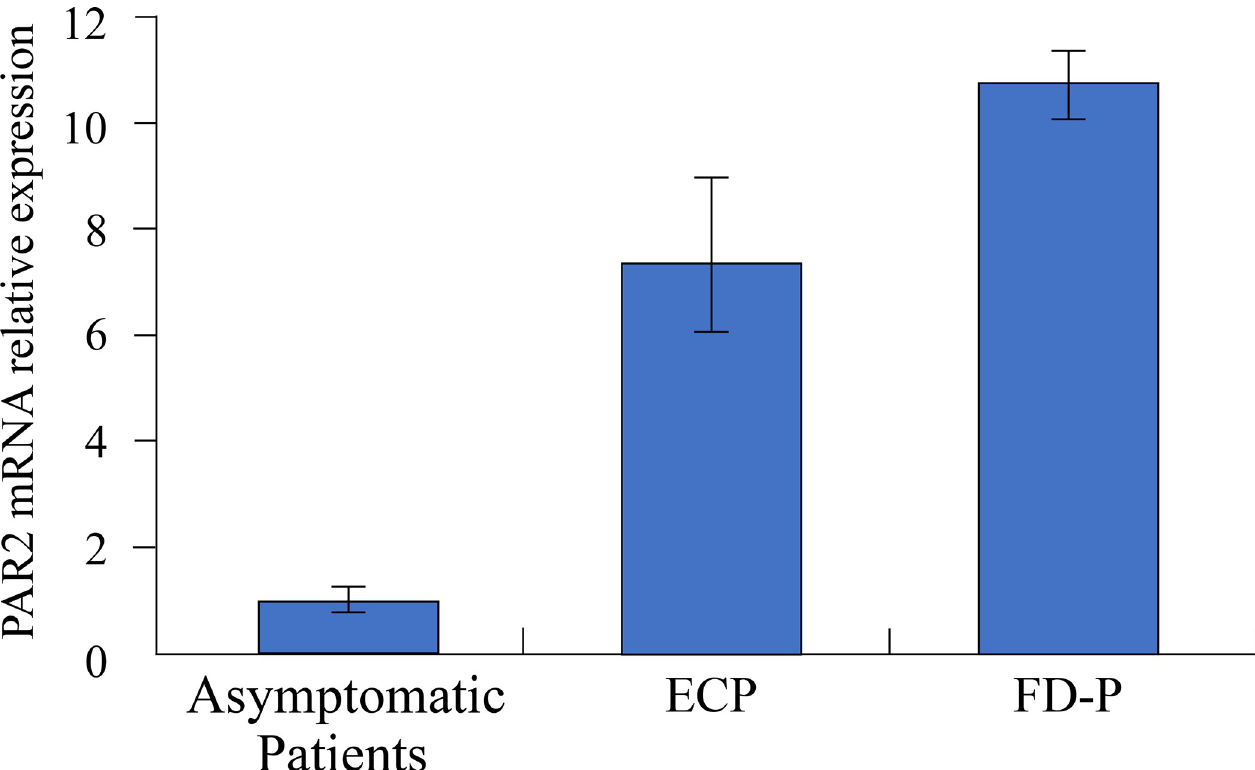
Fig 7. Comparison of PAR2 mRNA levels in duodenal mucosa of FD-P patients with ECP patients. PAR2 mRNA relative expression in the duodenal mucosa of patients with ECP (n = 4) and FD-P (n = 4) were significantly higher than those of asymptomatic patients (n = 12) using real-time PCR (Fig 7). However, there were no significant differences in PAR2 mRNA relative expression in the duodenal mucosa between ECP and FD-P patients (Fig 7). Results were compared using two-tailed, unpaired, t-tests.